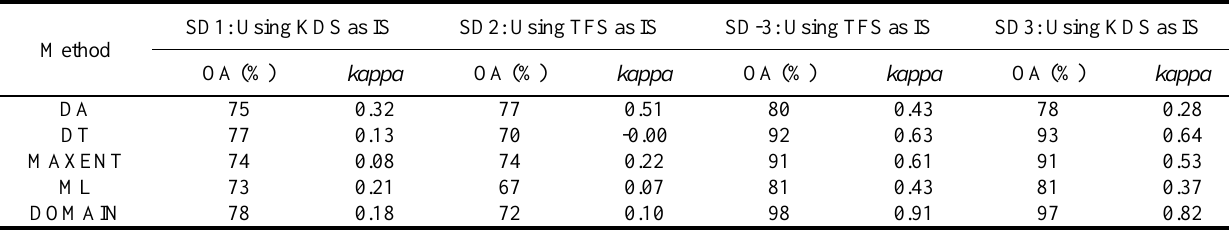
Table 2. The model evaluation result of each method in the three SDs.